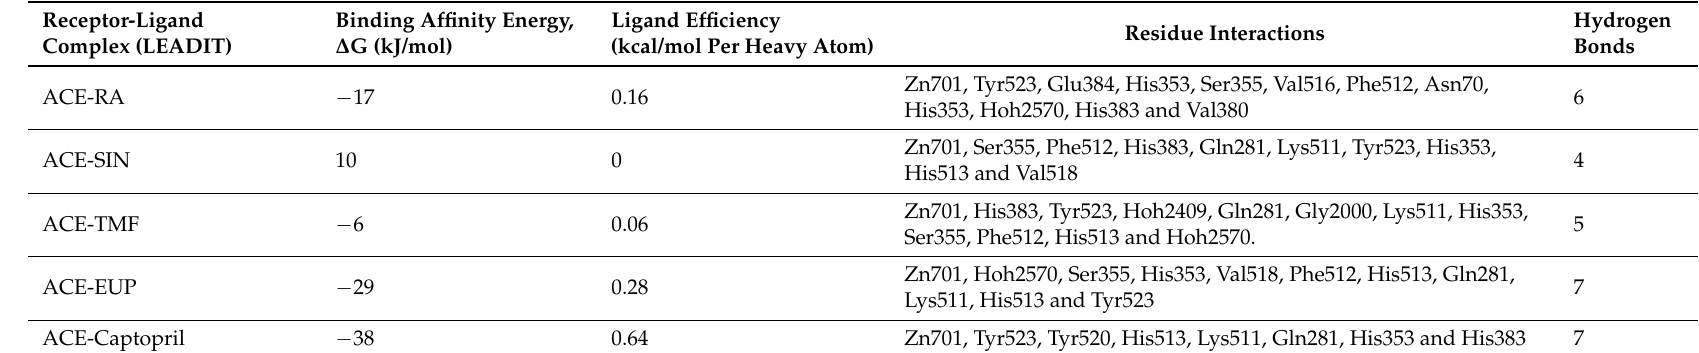
Table 3. Summary of the docking scores and reported binding affinities of RA, SIN, TMF and EUP compounds with ACE in the docking analysis with LeadIT FlexX Scoring